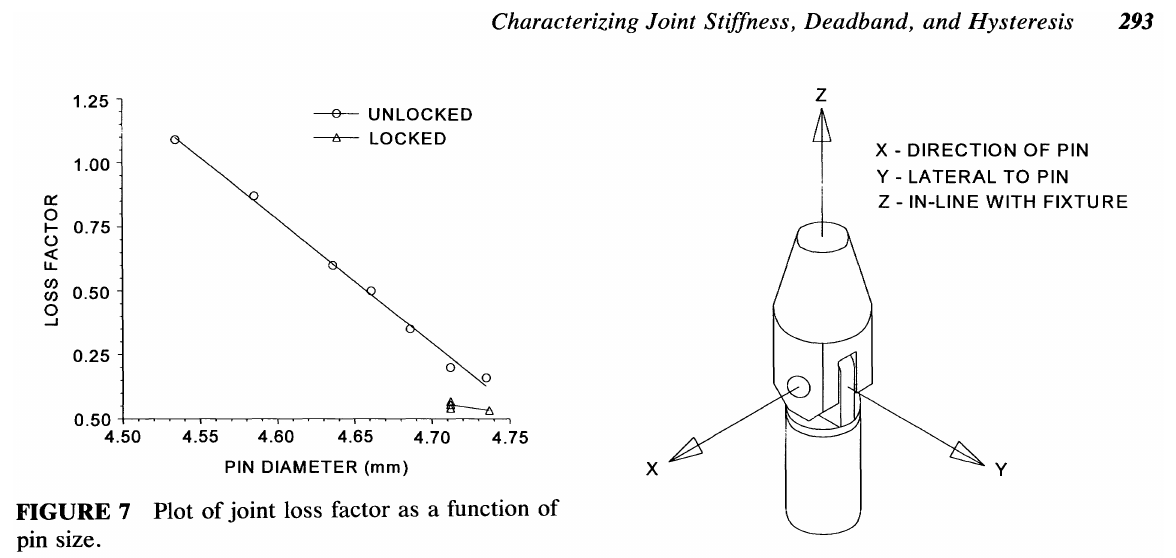
FIGURE 7 Plot of joint loss factor as a function of pin size.